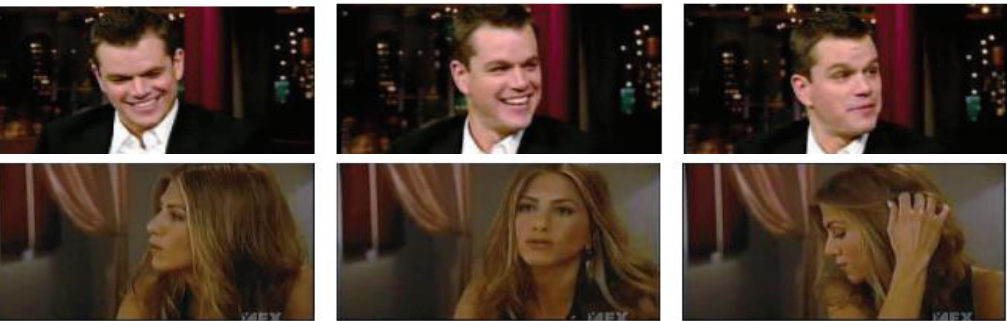
Figure 4. Sampling frames of two videos from YTC